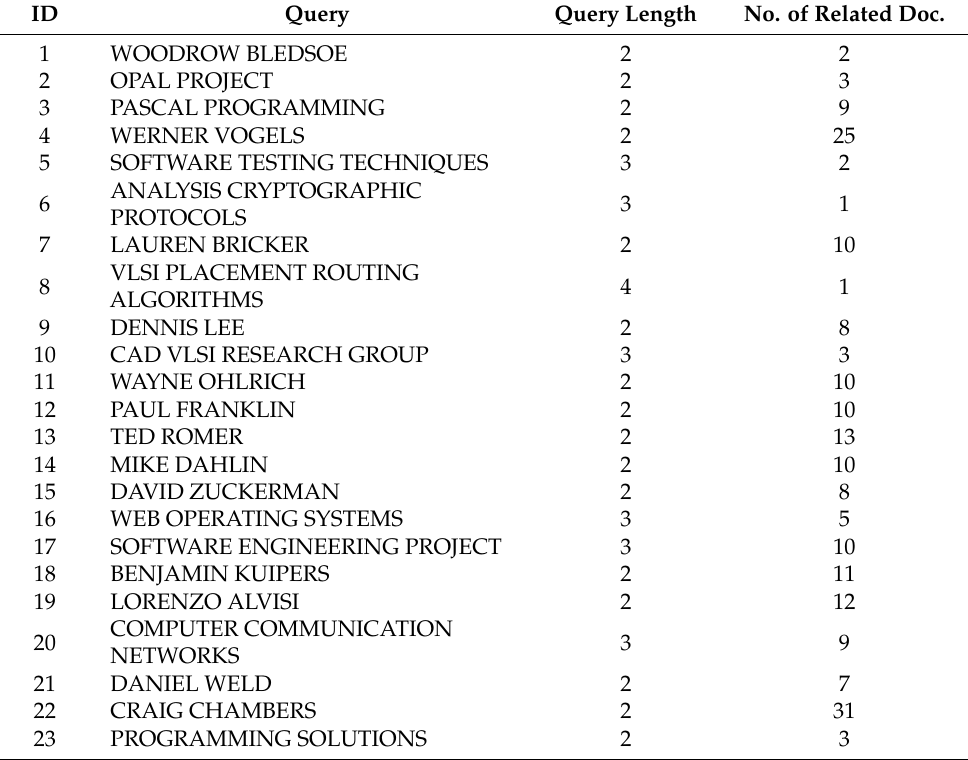
Table 7. List of a queries with length and number of related